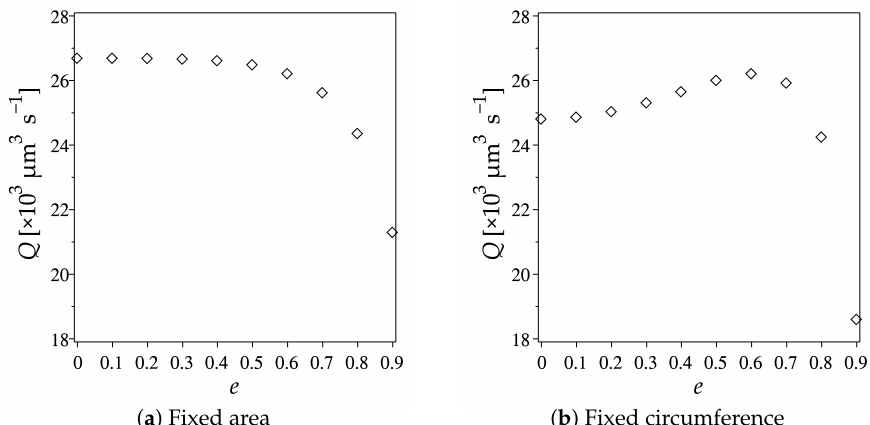
Figure 7. Variation of the flow rates of steady electroosmotic flow on various eccentricities with: ( a ) Fixed area of the channel cross-sections; ( b ) Fixed circumference of the channel cross-sections.